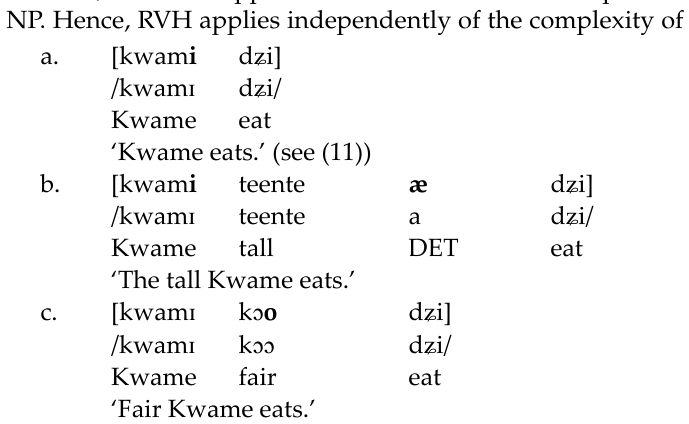
k ɔ t ʊ bebree ‘many